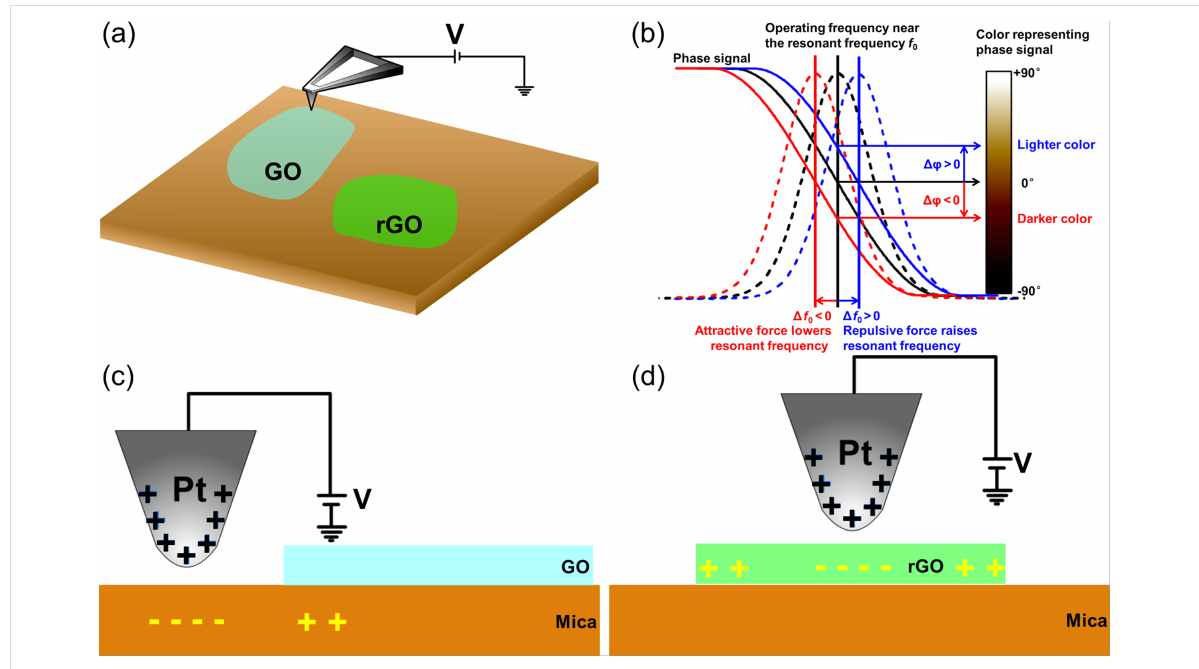
Figure 3: Illustrative diagram of EFM imaging and EFS: (a) schematic depiction of EFM, (b) electrostatic force between the biased tip and sample, causing a phase shift of the cantilever; EFM imaging of (c) GO or (d) rGO on mica substrate.